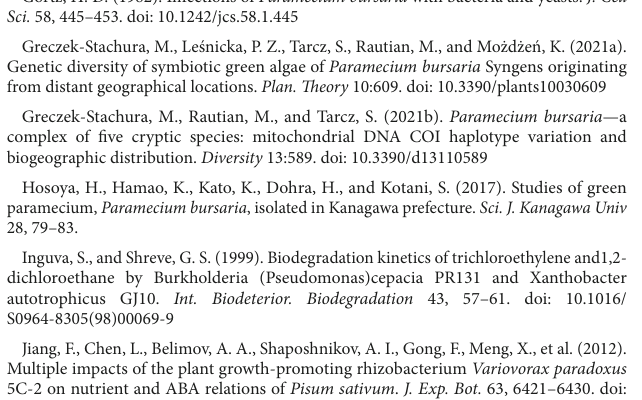
the poorly proliferating P. bursaria strains (six in blue) are indicated in Supplementary Table S1. Identified DNA sequences are shown on the righthand side. SUPPLEMENTARY FIGURE S1 Proliferation curves of P. bursaria isolated from long-term unfed cultures (KUHH-3 and 4) on three (October, November and December 2020; A , B and D ) and two (November and December 2020; C and E ) occasions, respectively. Statistical analysis was performed using the Kruskal–Wallis test, and each combination was significantly different ( p <0.05). Abbreviations are as follows, e.g. “liK3a”: “1” represents the data obtained from the first proliferation curve measurement in October, “iK” is the name of the person in charge, and “3” is the KUHH-3 strain. In addition, each person in charge isolated two strains for each proliferation experiment and cultured them separately; the final “a” and “b” represent the first and second proliferation experiment,